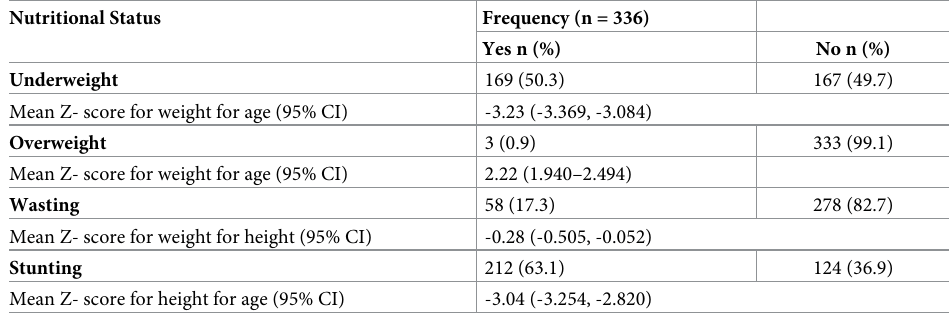
Table 3. Prevalence of Nutritional Status of under-five Muslim children in Kapilvastu district